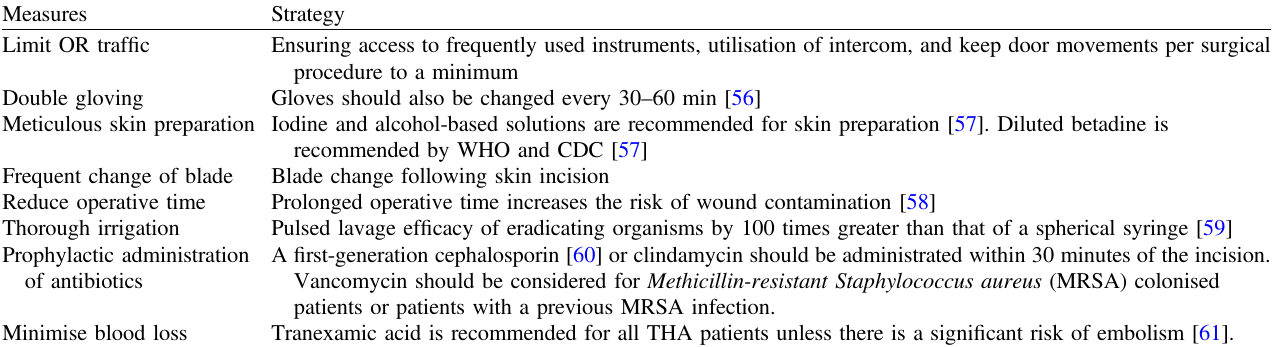
Table 3. Intra-operative measures and strategies for preventing